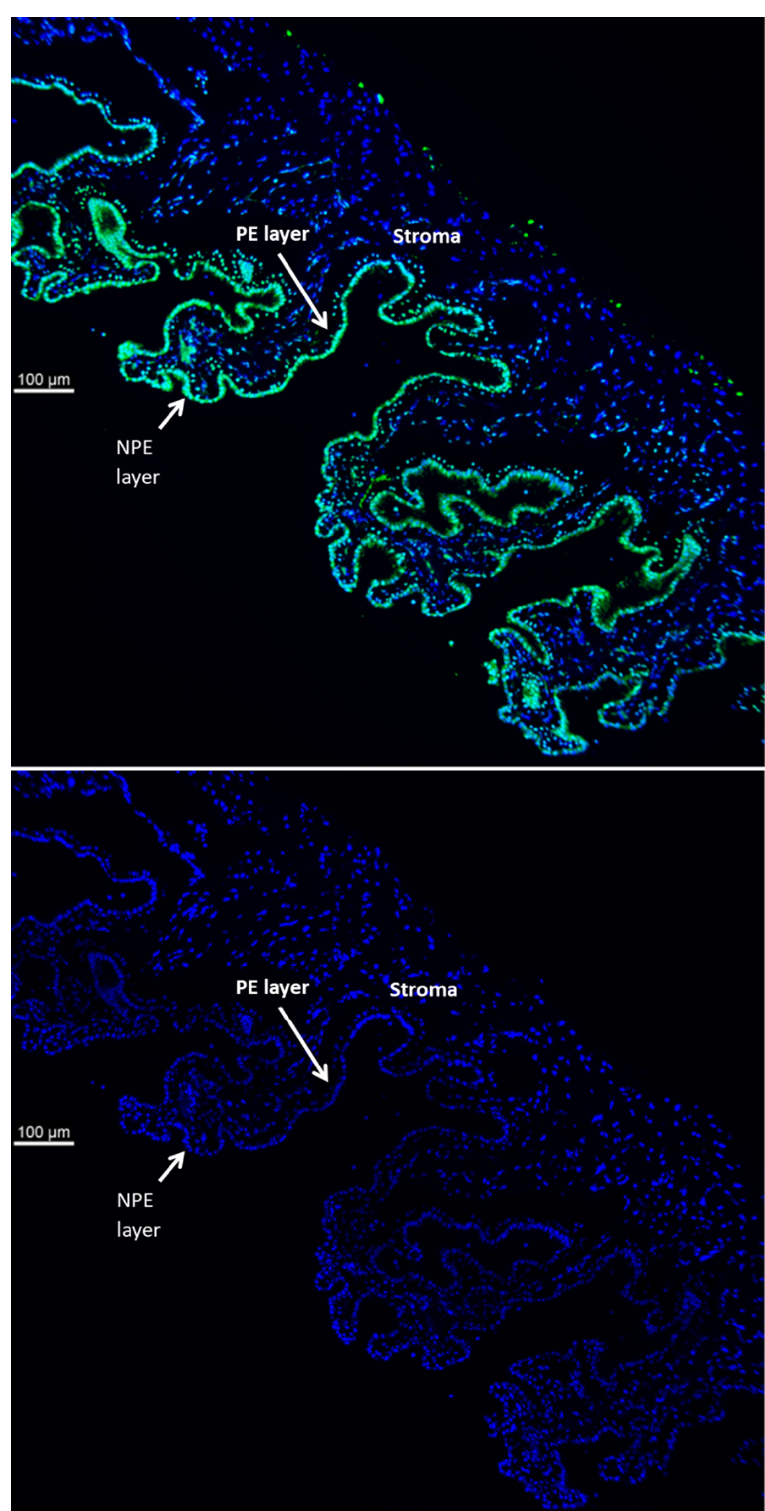
Figure 1. Immunolocalization of TRPV4 in the mouse ciliary body. TRPV4 (green) is abundant in the NPE (nonpigmented ciliary epithelium) cell layer at the surface but not the underlying pigmented ciliary epithelium (PE) cell layer or stroma. The lower panel shows a negative control in which no primary antibody was used.